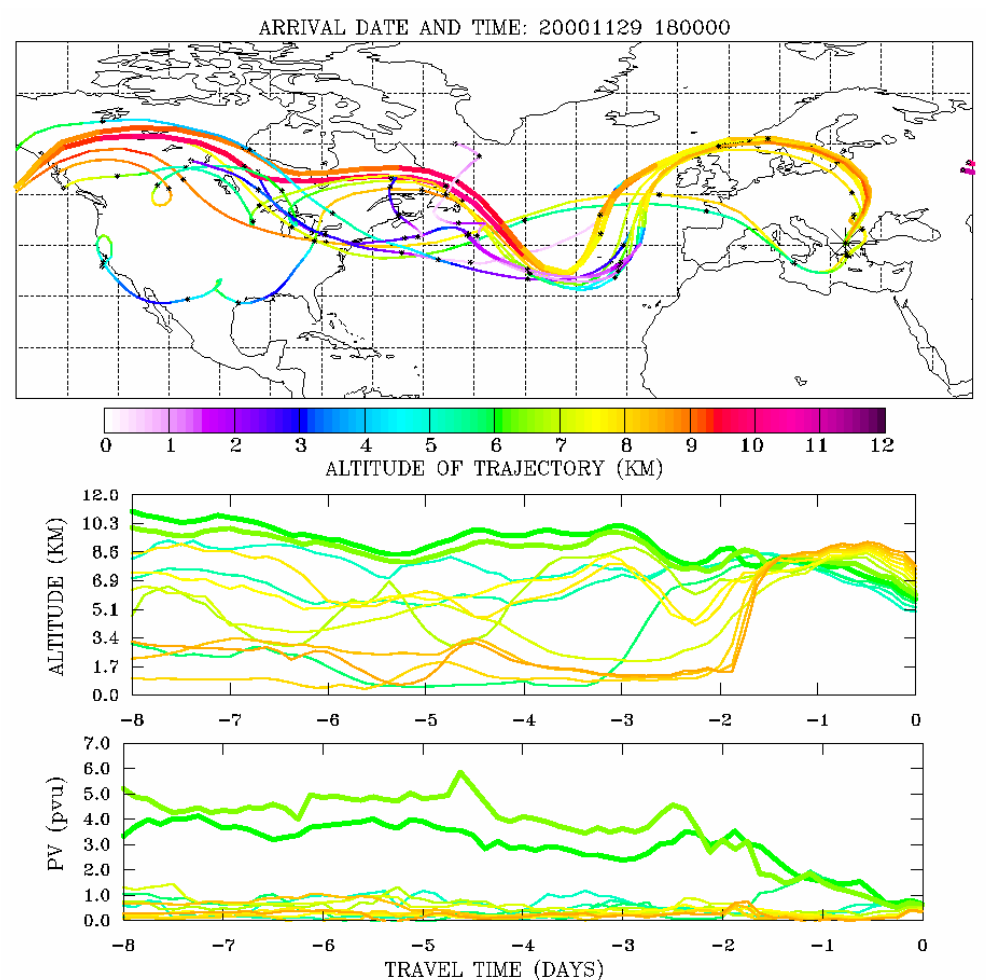
Fig. 8. Eight-day 3-D backward trajectories ending over Thessaloniki on 29 November 2000 at 18:00 UT. Top: Horizontal projection of trajectories with color-code scale according to the label bar referring to the actual heights (inkm a.s.l.). Middle: Time-height profiles of the trajectories of the top plot. Bottom: PV values (in PV u) along the various trajectories with the color-code scale corresponding to the middle